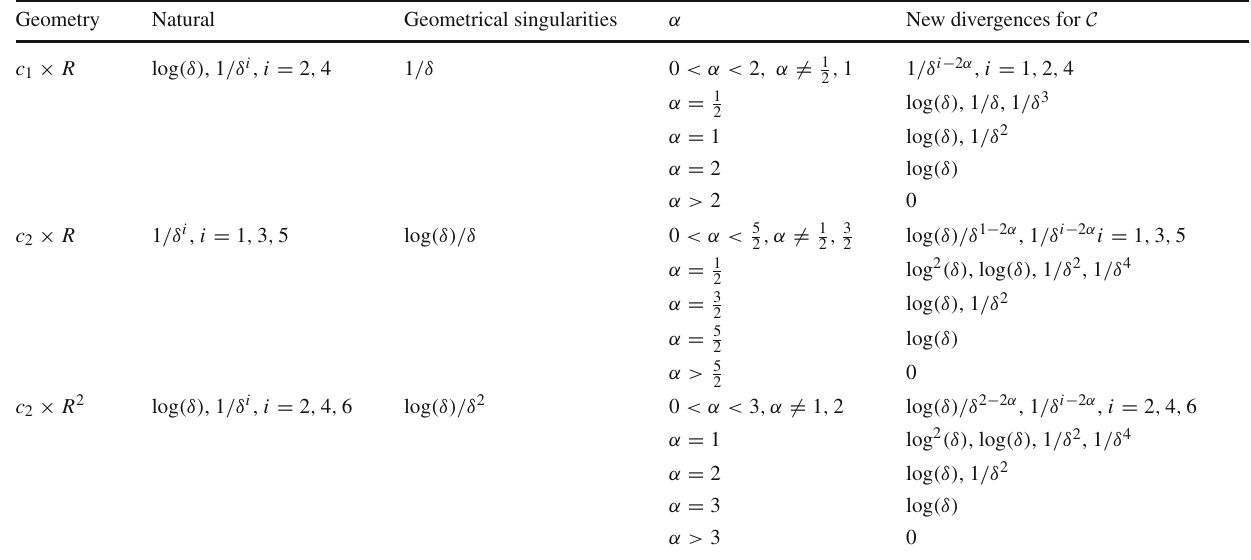
Table 6 Complexity for c n × R l